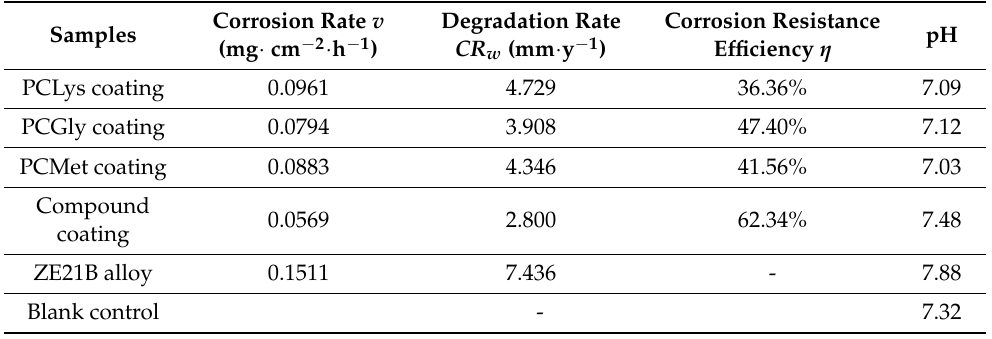
Table 2. Static weightlessness test for 24 h.